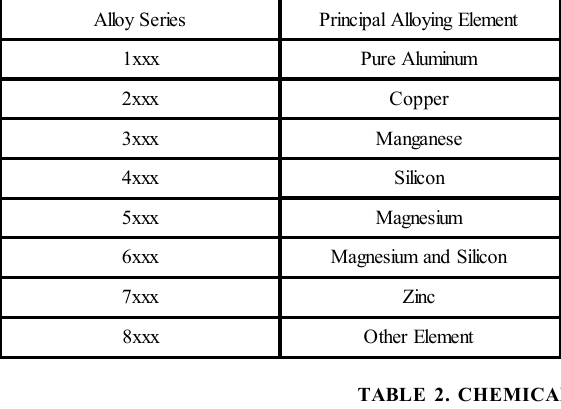
TABLE 1. ALUMINUM ALLOY SERIES AND THEIR ALLOYING ELEMENTS